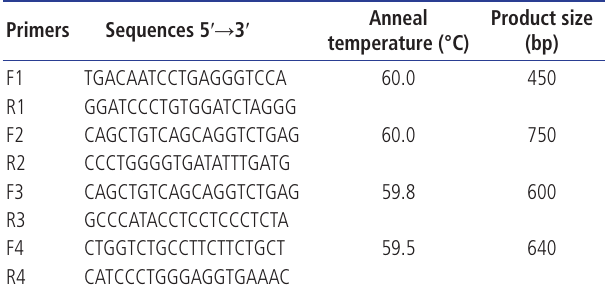
Table 1. Primers and annealing temperatures used for PCRs of the porcine